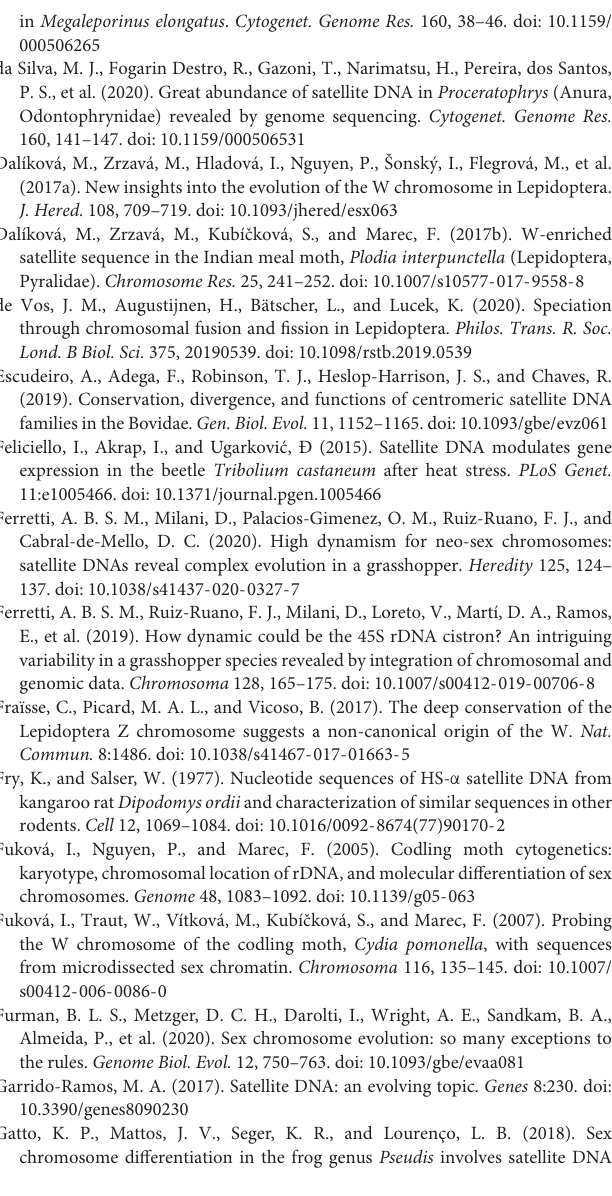
Supplementary Figure 3 | Orcein-stained polyploid nuclei obtained from Malpighian tubule cells of female (A,C,E) and male (B,D,F) larvae showing sex chromatin status in (A,B) Cydalima perspectalis , (C,D) Diatraea postlineella , and (E,F) Ostrinia nubilalis . Note the presence of a deeply stained W chromatin body (arrows) in females, while it is absent in males. Bar = 10 µ m. Supplementary Figure 4 | Cluster layouts and sequence logos for satDNAs. Graphical layouts were obtained from RepeatExplorer output. Sequence logos were generated from full-length consensus sequences from the most frequent k-mers for each satDNA. Supplementary Table 1 | DNA sequences of primers used for PCR amplification of seven satDNAs and 18S rDNA in Crambidae species. Cper, Cydalima perspectalis ; Dpos, Diatraea postlineella ; Onub, Ostrinia nubilalis . Supplementary Table 2 | Analysis of abundance of identified satDNAs at the interspecific level in the genomes of Crambidae